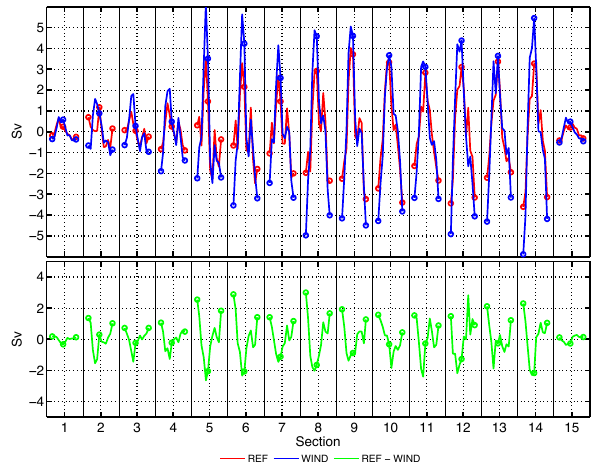
Fig. 12. The upper plot shows the anomaly of monthly ASC trans- port (compared to the annual mean transport of the ASC show in Fig. 11) across each section (horizontal axis) shown in Fig. 1. Each number corresponds to one section, and for each section, the circle on the left is January, then June and the circle on the right is De- cember. The blue line is for WIND and the red line for REF. The bottom plot shows the difference between REF and WIND simula- tions (green line). A negative value means a stronger ASC in WIND